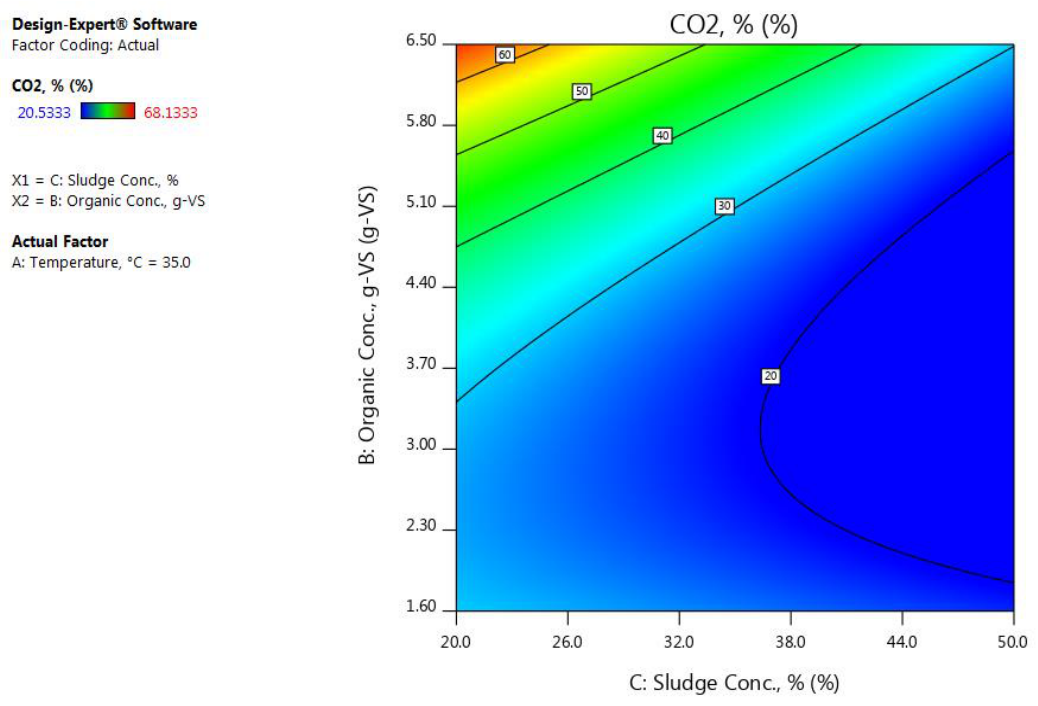
Figure 11. Contour plot shows the influence of the BC interaction on the CO 2 %.